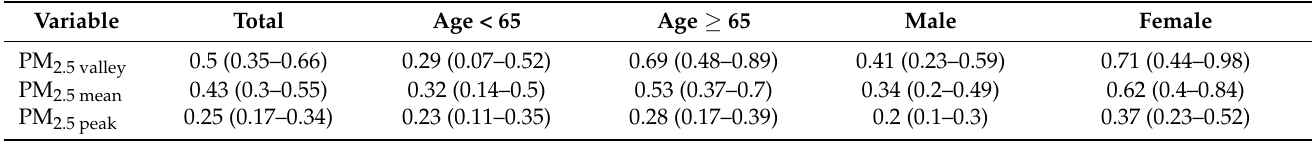
Figure 1. The excess risk (%) and 95% confidence interval in AMI hospital admissions for per 10-unit increase in hourly valley concentration of six kinds of air pollutants in different lag days among the total population in Beijing, China. Table 2. The excess risk (%) and 95% confidence interval in AMI hospital admissions for per 10 units increase in hourly peak, mean, and valley concentration of six kinds of air pollutants in the current day (LAG0) among the total population and different subgroups in Beijing,